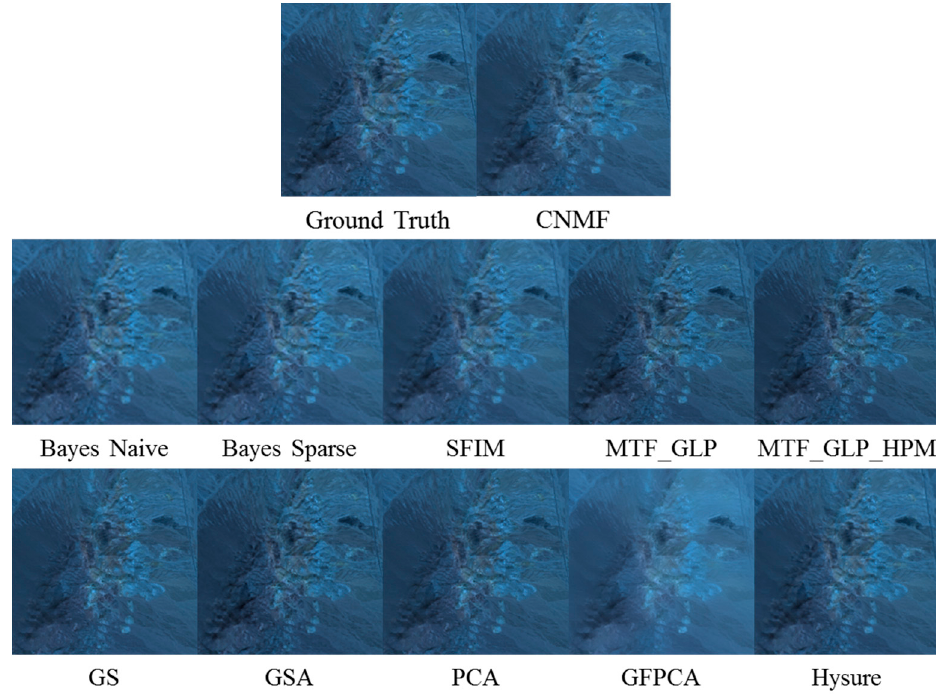
Figure 5. Fused AVIRIS images using different methods in the VNIR range.